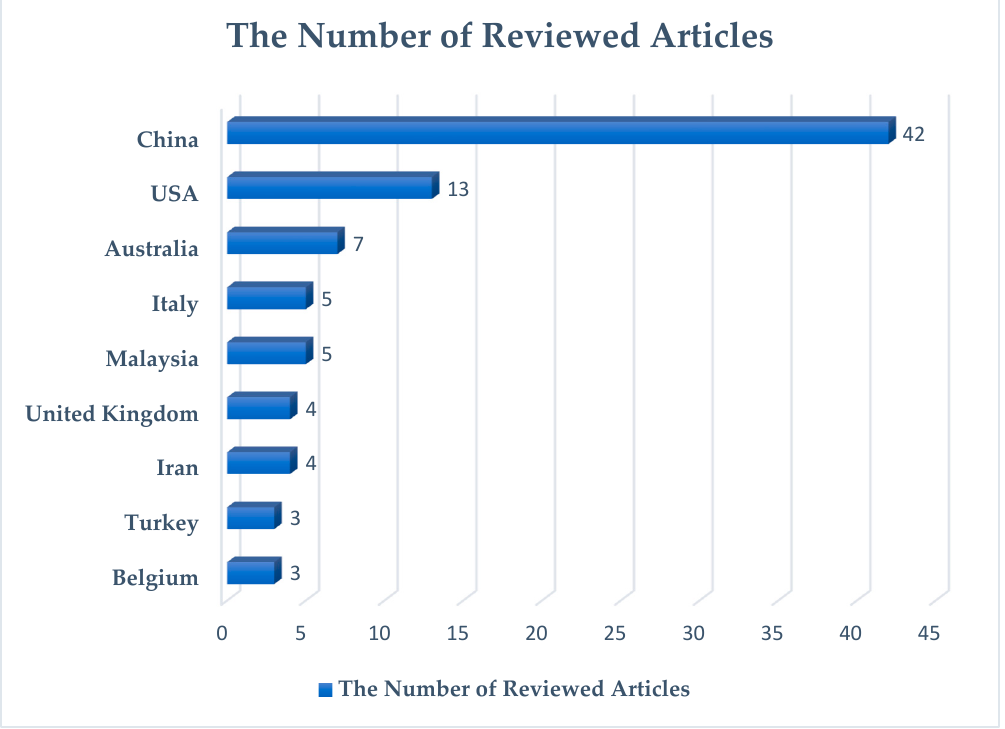
Figure 5. The Number of Reviewed Articles Published Per Country or Region.